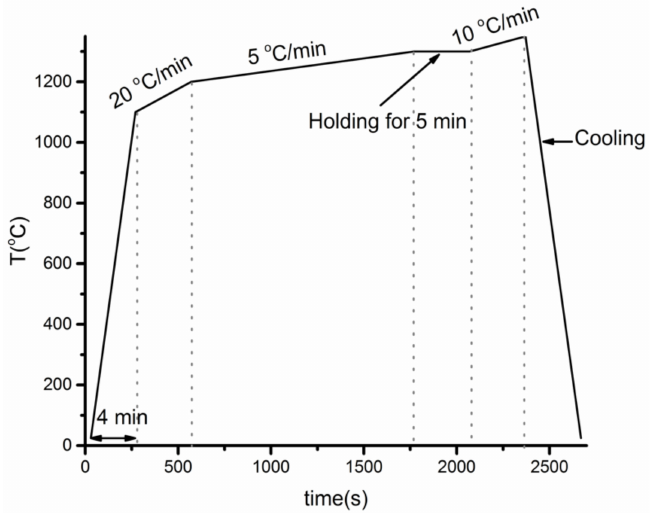
Figure 1. Temperature profile of the Fe-26Si-9B particle on Si 3 N 4 substrate under 10 − 4